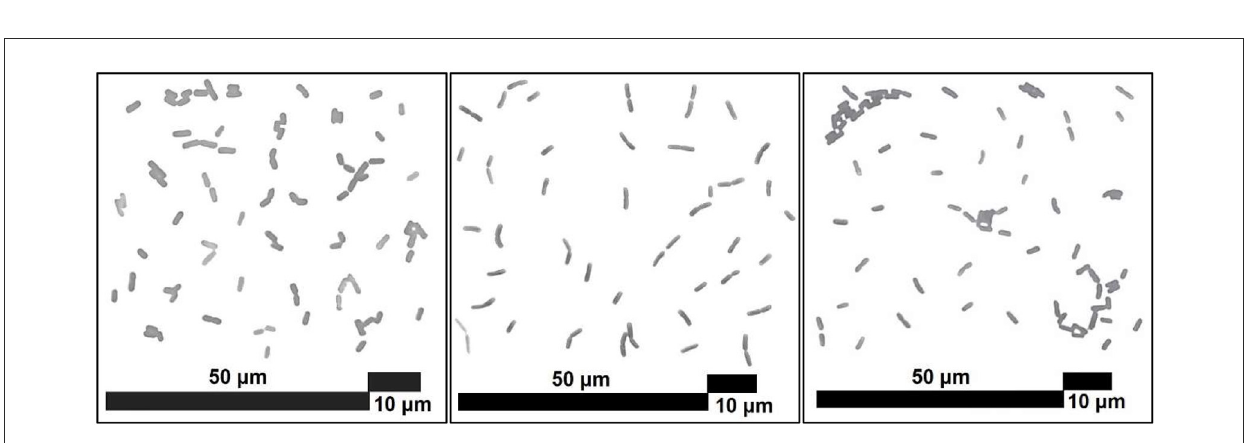
FIGURE7 Optical microscope micrograph of the Fructilactobacillus spp. H-Sp-0-3 (left), Fructilactobacillus spp. H-Mb-01 (center) and Fructilactobacillus spp. H-Sp-0-2 (right).